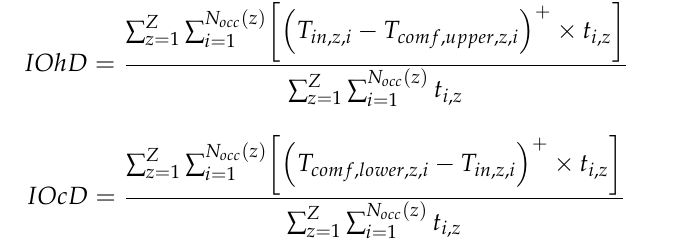
Figure 5. Reference building measurement locations used for the energy use evaluation: ( a ) cooling energy (electricity) use (kWh); ( b ) heating energy (natural gas) use (kWh).